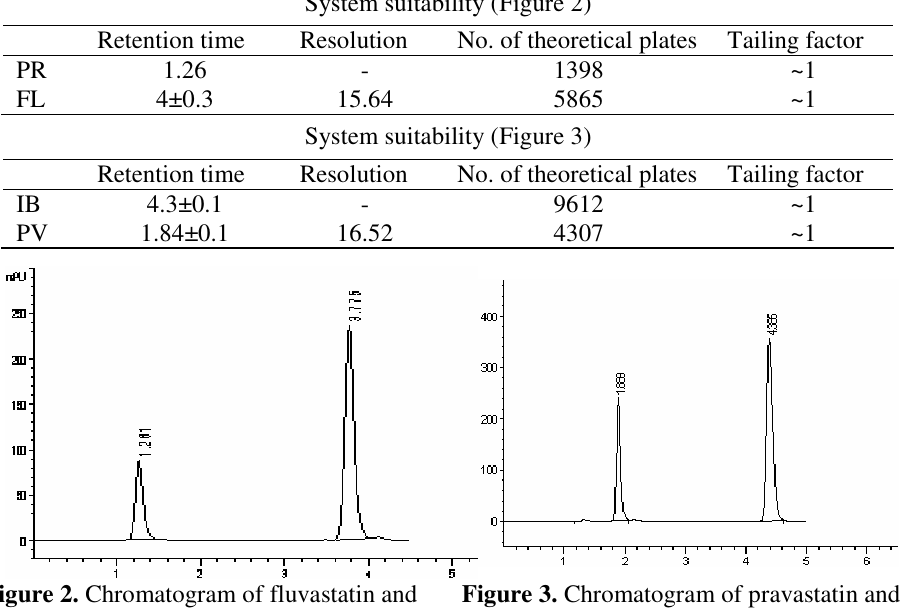
Figure 2. Chromatogram of fluvastatin and internal standard pyridoxine HCl